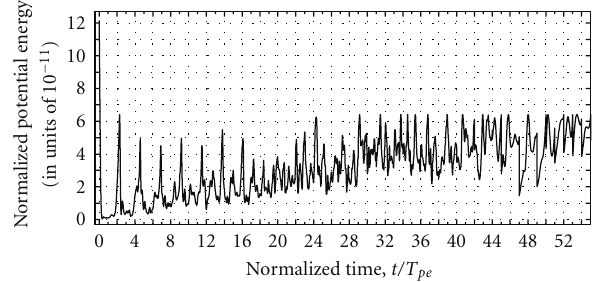
Figure 2: The time variation of the normalized potential energy of the plasma filling up all simulation region, W pot ( t ) /W 0 results were obtained for the first situation with the start from the completely electrically neutral state. The values are given in units of 10 − 11 . The normalized time, t/T pe , that is, the time in units of the equilibrium period of Langmuir oscillations of electrons, T pe , is shown on the